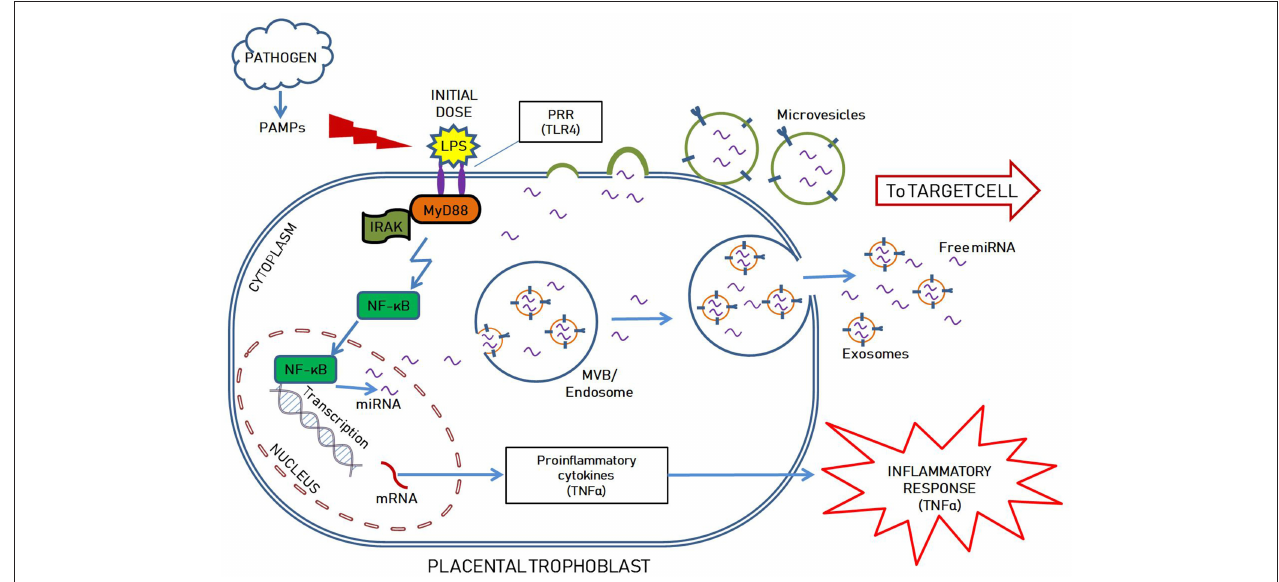
FIGURE 1 | Hypothetical illustration showing LPS mediated inflammatory response, possible mechanism of anti-inflammatory miRNAs mediated endotoxin tolerance as well as packaging within extracellular vesicles (EVs; including exosomes and microvesicles) in a placental trophoblast. The initial LPS dose stimulates TLR4 pathway in the placental trophoblast to prompt the initial inflammatory response, while also upregulating miRNA transcription. The miRNAs are either found freely in the cytoplasm and released outside the cells, or selectively packaged into extracellular vesicles by various mechanisms. Exosomes are formed intraluminally in the endosomal system within multivesicular bodies (MVB) while microvesicles are secreted by membrane derived vesicle formation. They are selectively packaged with nucleic acids (DNAs, mRNAs, miRNAs), proteins, lipids and carbohydrates, specific to the cell of origin and the intended target. The EVs and free miRNAs are transported to the target cell via the extracellular